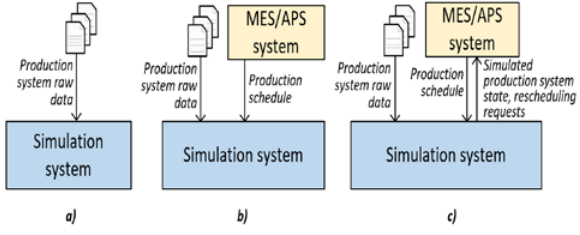
Fig. 1 . Different approaches to simulation modeling